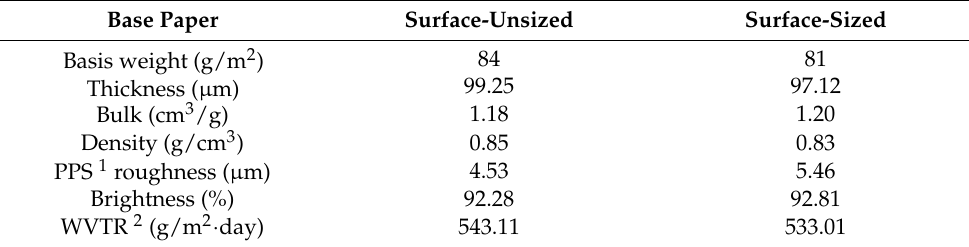
Table 1. Comparison of the properties of the two base papers.